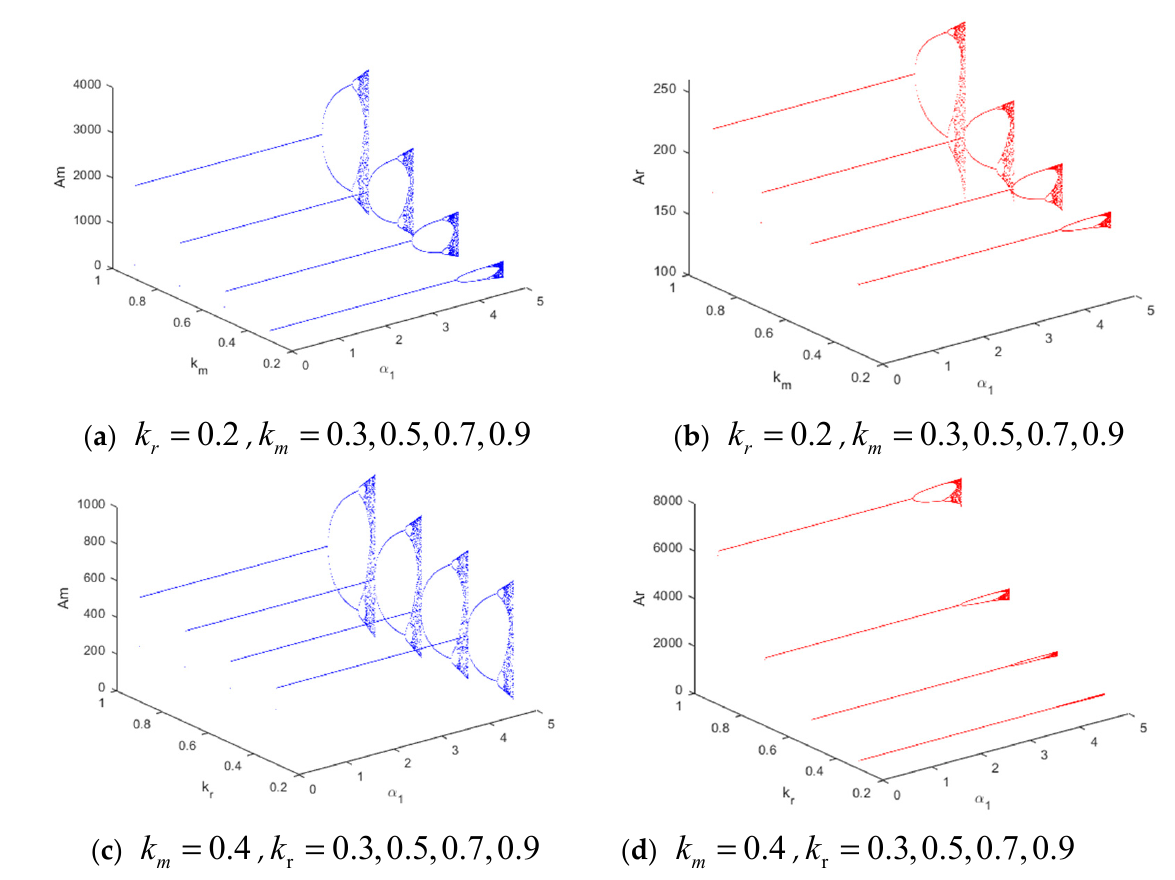
Figure 15a,b are the 3D bifurcation diagrams with respect to the parameters α 1 , k m , , A m and α 1 , k m , A r , respectively. Figure 15c,d are the 3D bifurcation diagrams with the parameters α 1 , k r , A m and α 1 , k r , A r , respectively. Researchers can find that the Nash Figure 14. The 2D bifurcation diagram with respect to equilibrium ( A m , A r ) is changed with effect coefficients k m and k r . As shown in Figure 15a,b, k . and the values of the Nash equilibrium ( A m , A r ) increase with the increase in k m . As shown in r Figure 15c,d, the increase in k r can increase the values of the Nash equilibrium ( A m , A r ) . Meanwhile, the bifurcations and the chaos of the system are indicated clearly.